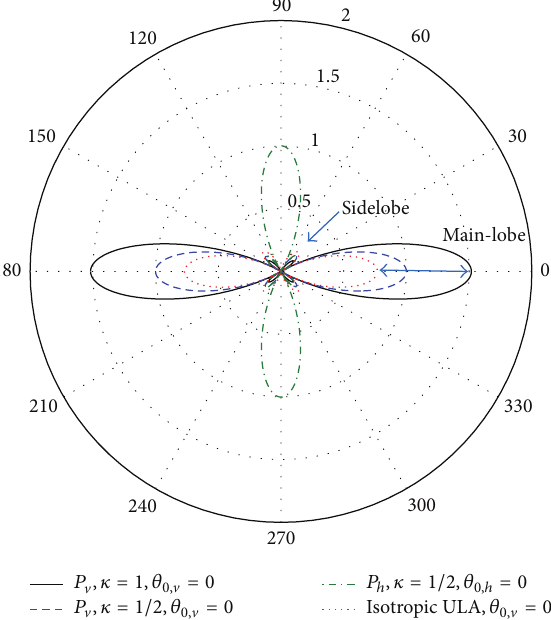
Figure 7: Beam radiation patterns of the PULA in 2D form.